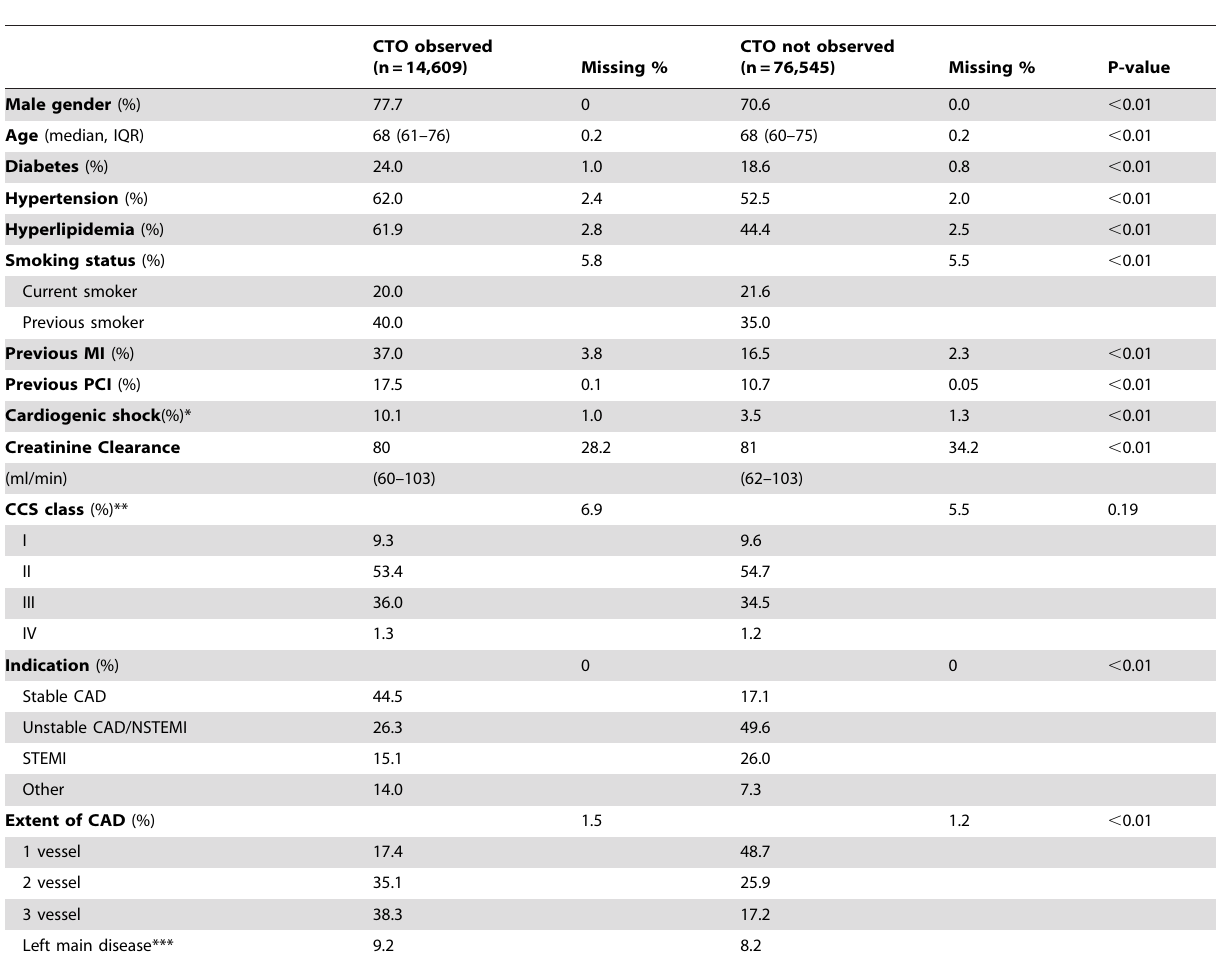
Table 2. Baseline characteristics of patients from coronary segment subcohort with coronary artery disease, stratified for the presence of a CTO observed on angiography.